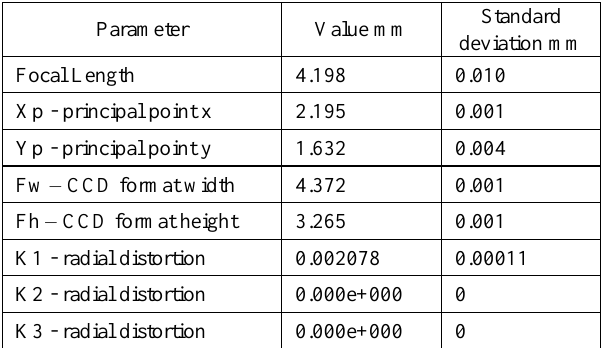
Table 2. Self-calibration results for the iPhone 4G